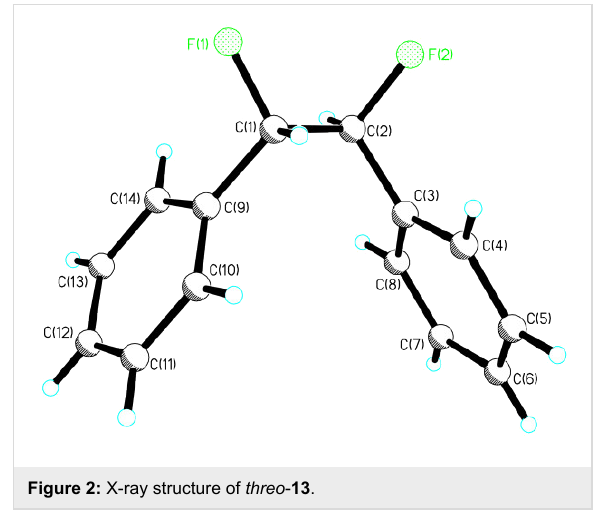
Figure 2: X-ray structure of threo - 13 .